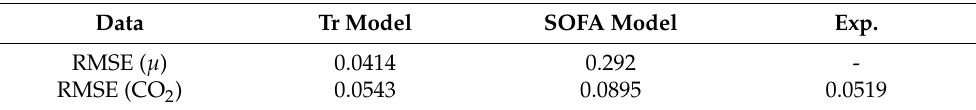
Table 10. Root Mean Square Error (RMSE) for the calibration of the growth function µ and the CO 2